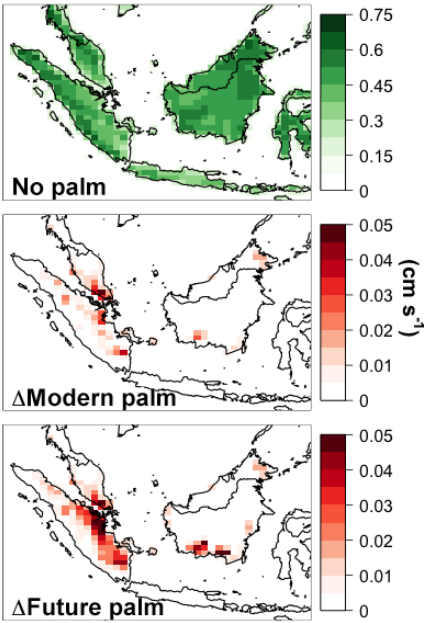
Figure 7. Annual average surface formaldehyde (HCHO) concen- trations over SEA (top) and the change due to Modern (middle) and Future (bottom) Palm